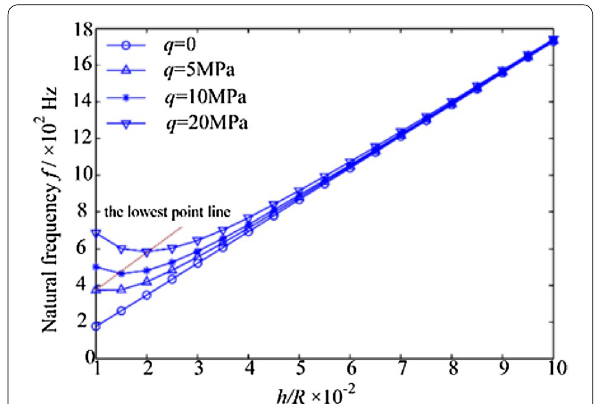
Figure 2 Variation of the natural frequency against h / R ratio for several uniformly distributed